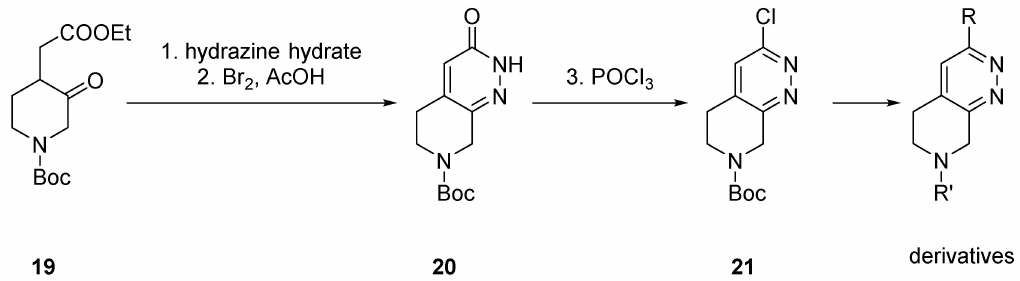
Scheme 4. 5,6,7,8-Tetrahydro derivatives of pyridopyridazines from 3-piperidones. The 4-methyl-3-cyano-pyridine-2,6-diones 22 are easily available from the condensa- tion reaction of acetoacetate esters and N-arylcyanoacetamide. Azo coupling with phenyl- diazonium salt then gave the hydrazone 23 . The latter underwent a one-pot conversion with dimethyl formamide dimethylacetal (DMFDMA) to an enamine 24 , followed by cyclo- condensation with evolution of dimethylamine, affording the 6,8-dione derivative 25 . The reaction takes place either in xylene at reflux (77% yield) or solventless after microwave irradiation (no yield given, Scheme 5) [22].